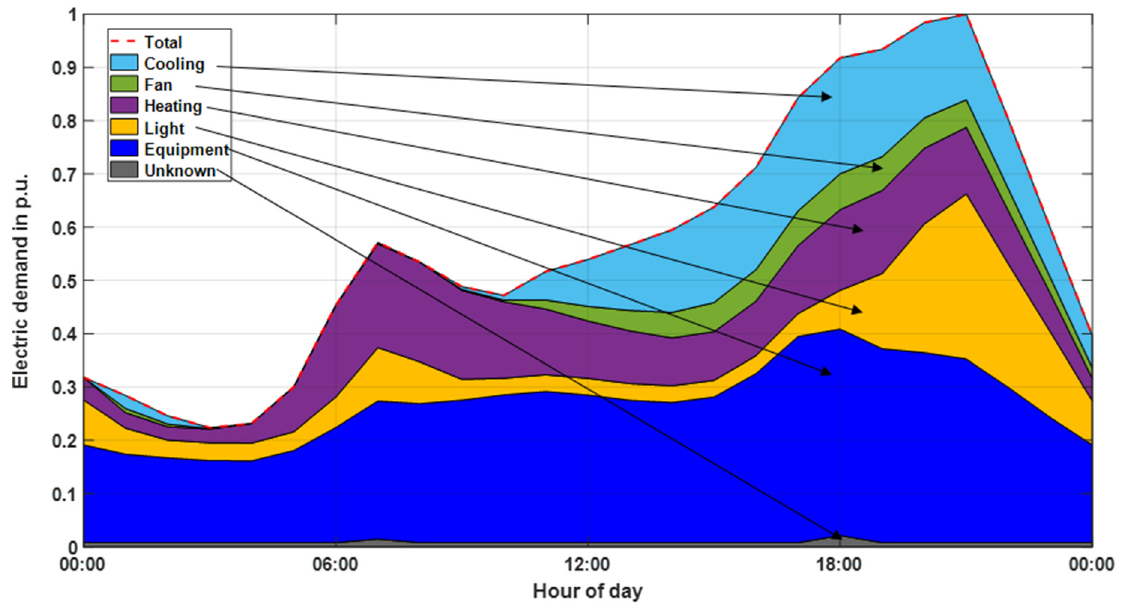
Figure 5. Instantaneous electric demand on an electrical peak day in hourly intervals for Harrisburg, USA.